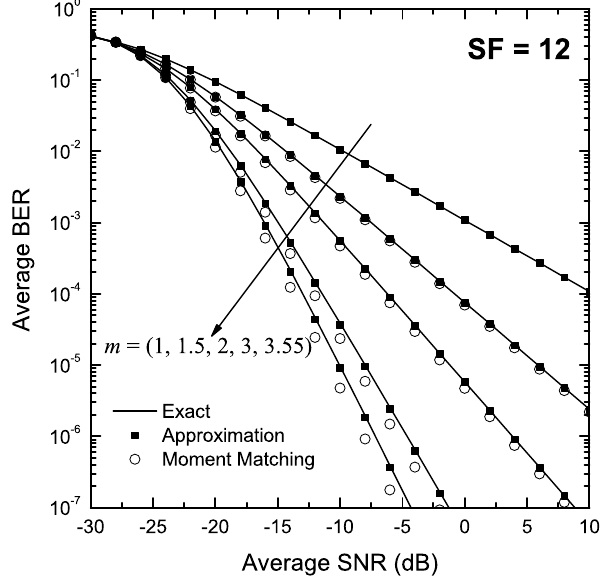
Figure 3. BER of LoRa systems operating in the presence of Nakagami- m fading as a function of the SNR, γ , for SF = 12 and various values of m .